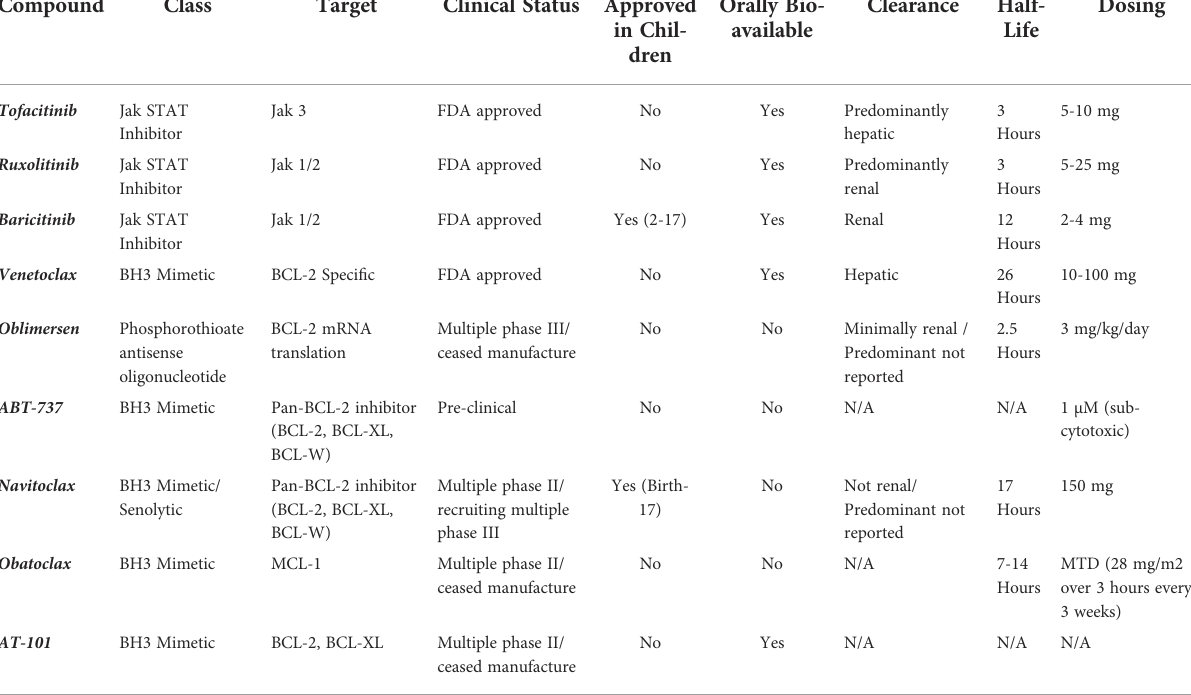
TABLE 1 Report of drug class, cellular target, clinical trial status (phase I, II, III, approved, terminated), approval in children, oral bioavailability, route of clearance, compound half-life and dosing for Jak and BCL-2 inhibitors.